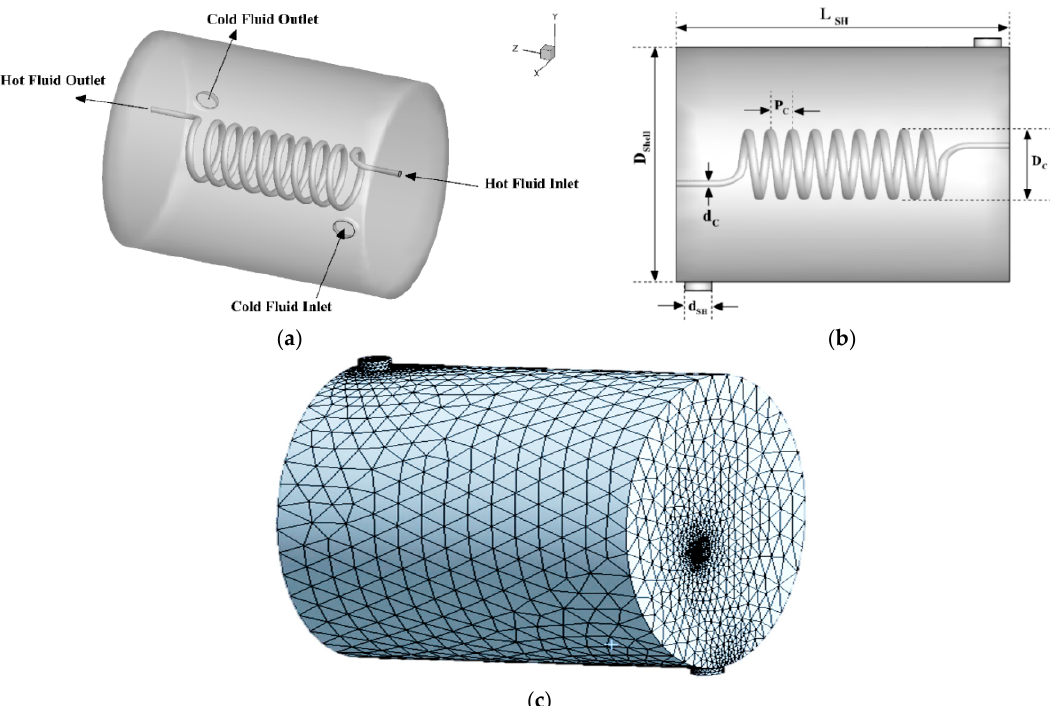
Figure 2. ( a ) Computational domain with inlet and outlet positions of the hot and cold flows; ( b ) Computational domain with the relevant geometrical parameters of the shell and coil tube heat exchanger; ( c ) corresponding mesh grid.